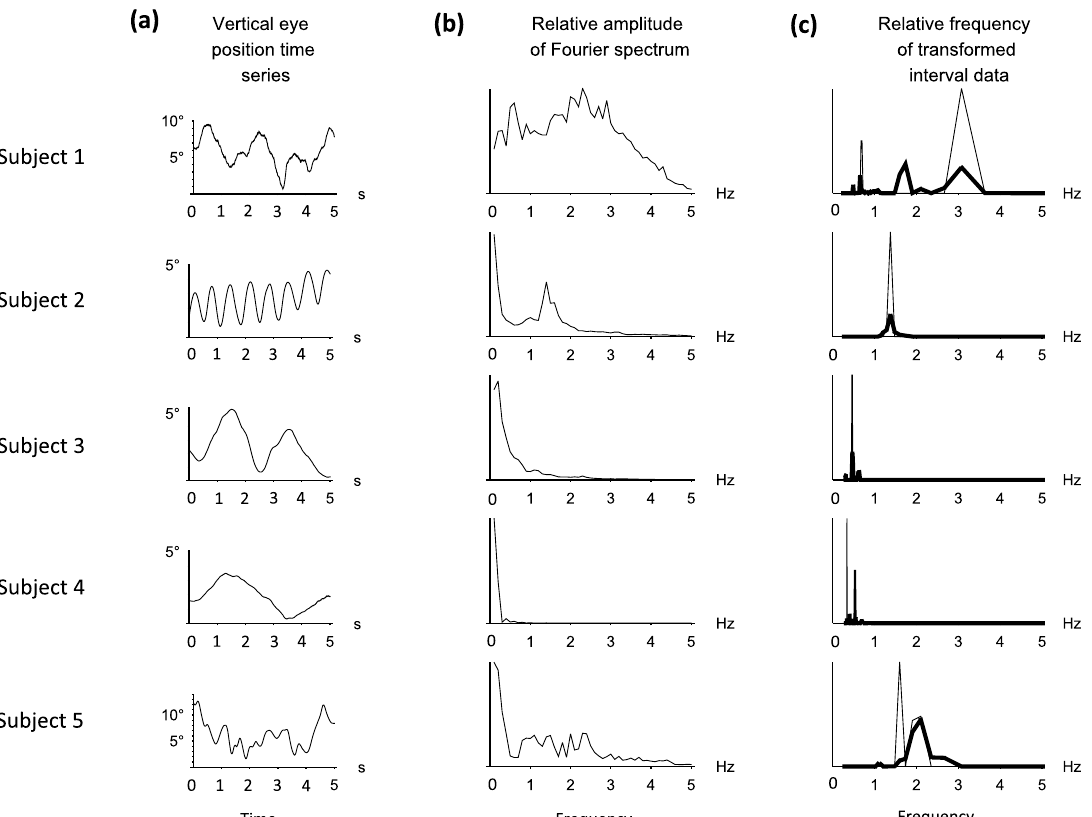
Figure 5. Periodicity analysis. ( a ) 5 s samples of the time series from each subject. See Fig. 3 for the full time courses. ( b ) Frequency spectra. ( c ) Unstable periodic orbits (UPOs). UPOs were determined by comparing the relative frequency of the transformed interval data (thin lines) with surrogate data (bold lines). See text for further